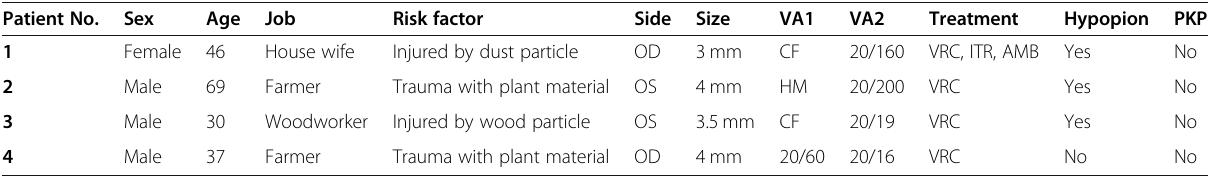
Table 1 Clinical details of patients involved in this study Patient No.